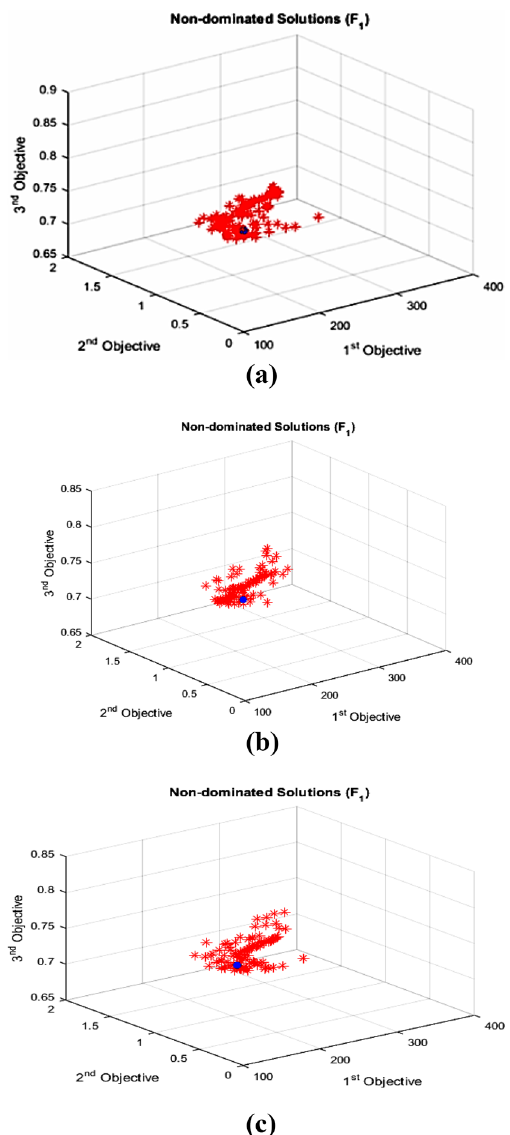
Fig. 6 The graph of the value target functions in the 33-bus network, a unit resulting, b 0.85 Post-phase, c 0.85 pre-phase